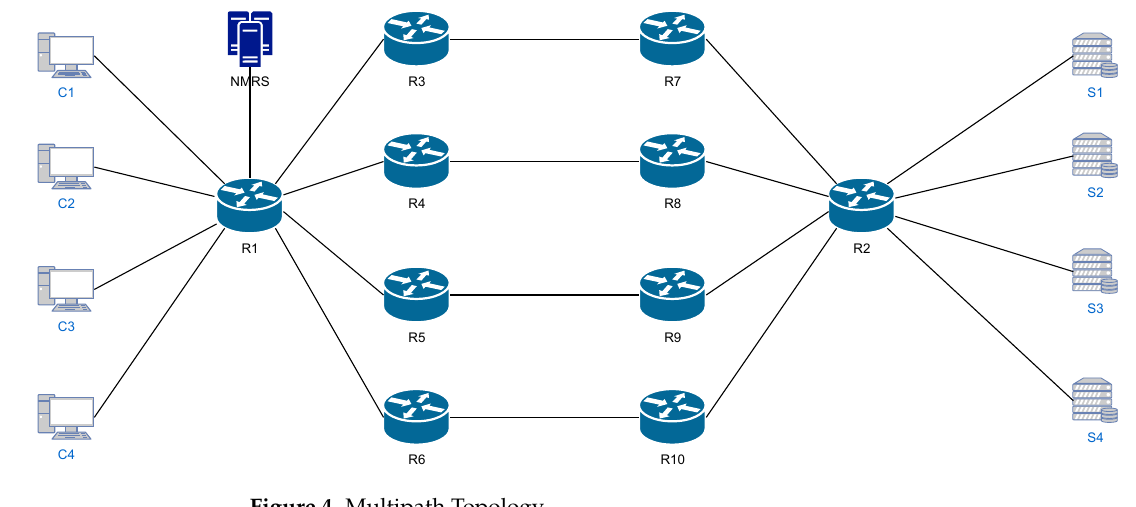
Figure 4. Multipath Topology.